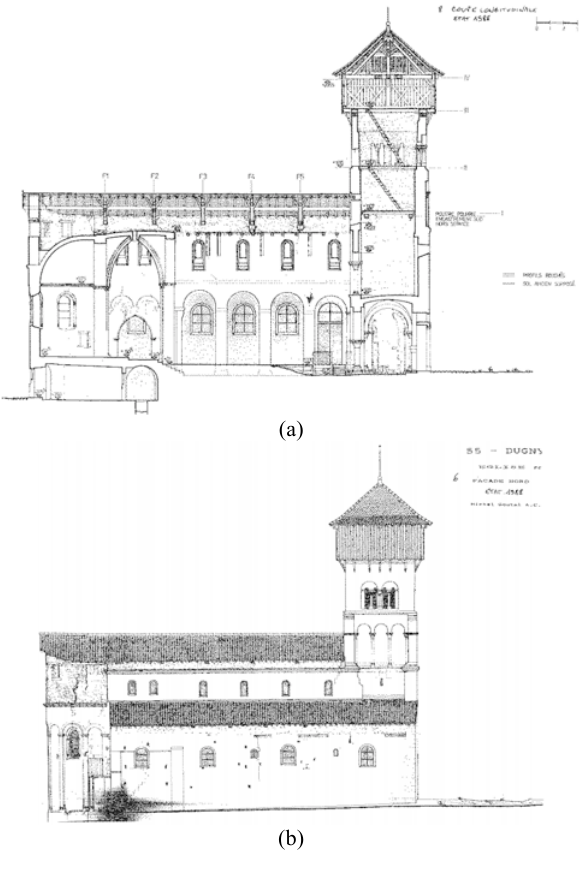
Figure 3. Geodetic GNSS measurements around the